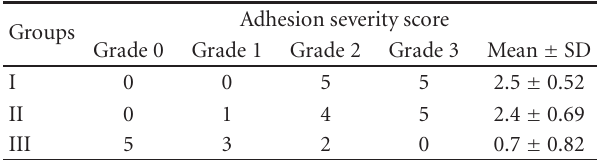
Table 3: Macroscopic adhesion severity grades and mean group